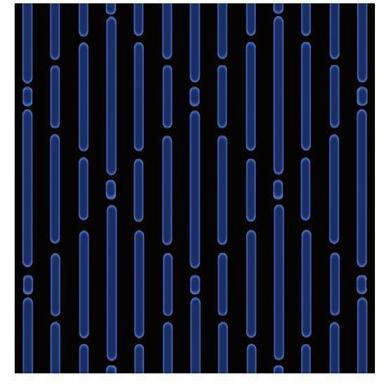
Schematic illustration of a bionic engineering topology based on a PDMS surface.